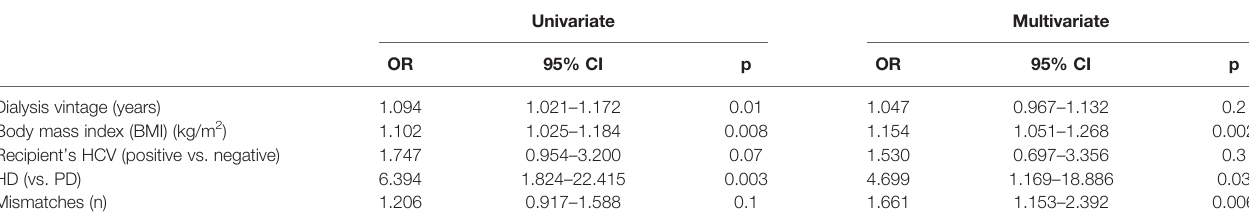
TABLE 6 | Univariate and multivariate analyses of the features of Group C associated with